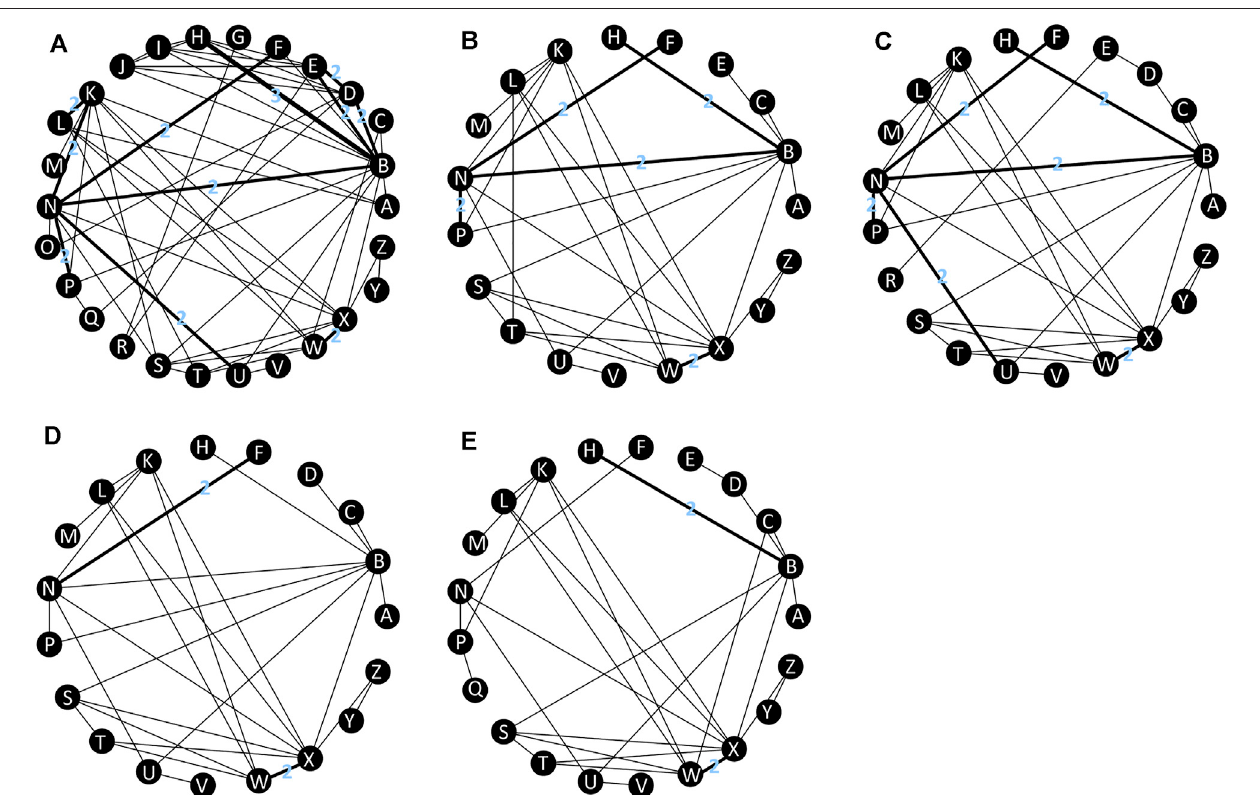
FIGURE 2 | Network plot of treatment outcomes in terms of (A) virological suppression, (B) adverse events, (C) serious adverse events, (D) drug-related adverse events, (E) subgroup analysis. All connecting straight lines are based either on single studies or in case this does not hold true, then every connection with n > 1 should show the actual n. A: DOR + TDF + XTC; B: EFV + TDF + XTC; C: EFV400 + TDF + XTC; D: EFV + ABC+3TC; E: EFV + AZT+3TC; F: NVP + TDF + XTC; G: NVP + AZT+3TC;H:RPV+TDF +XTC; I:RPV +ABC+3TC; J:RPV +AZT+3TC;K:DRV/b+TDF +XTC;L: DRV/r+ABC+3TC;M:DRV/c +TAF+FTC;N: ATV/r+TDF + XTC; O: ATV/r + ABC+3TC; P: LPV/r + TDF + XTC; Q: LPV/r + ABC+3TC; R: LPV/r + AZT+3TC; S: RAL + TDF + XTC; T: RAL + ABC+3TC; U: EVG/c + TDF + XTC; V: EVG/c + TAF + FTC; W: DTG + TDF + XTC; X: DTG + ABC+3TC; Y: DTG + TAF + FTC; Z: BIC + TAF + FTC. ABC: abacavir; ATV: atazanavir; AZT: Azidothymidine;